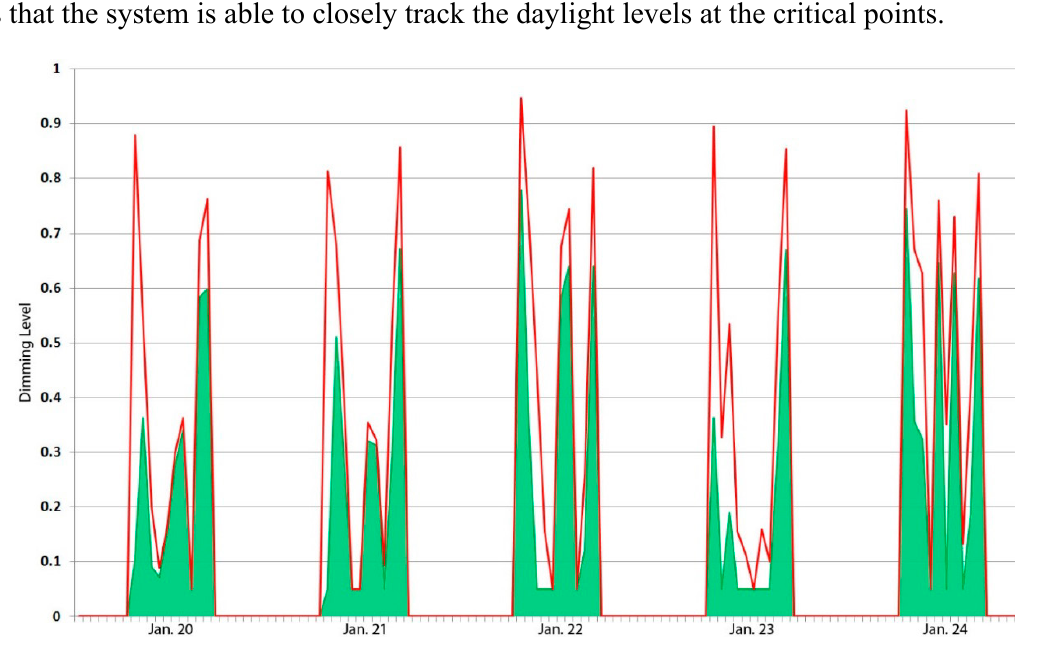
Figure 7. Comparison of hourly dimming levels for a control zone under photosensor control (red) with a calibrated control algorithm that limits overdimming at the critical work plane analysis points to 2% of the occupied hours (green shaded